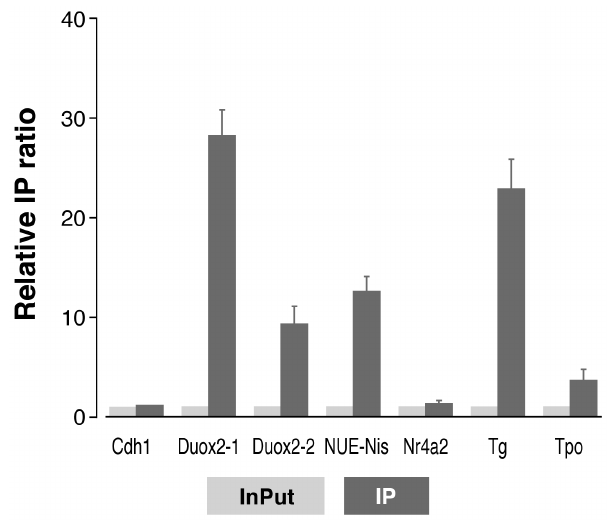
Figure 4. ChIP experiments for FoxE1 binding to selected genes. qPCR analysis of chromatin immunoprecipitation performed on PCCl3 cells with FoxE1 antibody. The enrichment of target sequences was calculated as the IP ratio (arbitrary units) relative to the negative control Afm, and normalized to their relative amplification in the input sample. Sequences from the Tg and Tpo promoters were used as positive controls. Two regulatory regions were analysed in the Duox2 promoter (called Duox2-1 and Duox2-2). Results are mean 6 SEM of two independent experiments, each performed in triplicate.